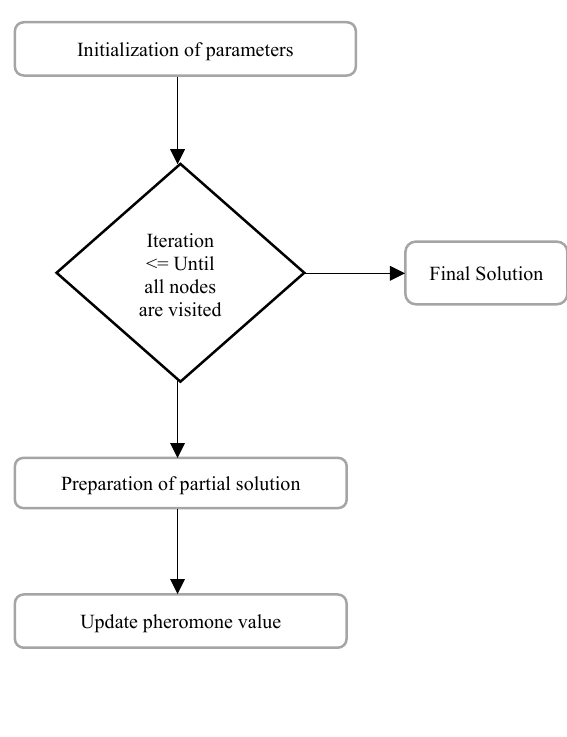
Figure 4. Flowchart of ACO